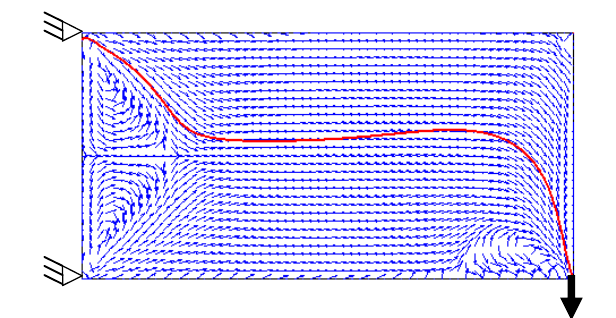
Fig. 5. Load flow orientation and load trajectories traced from reaction points with force equilibrium